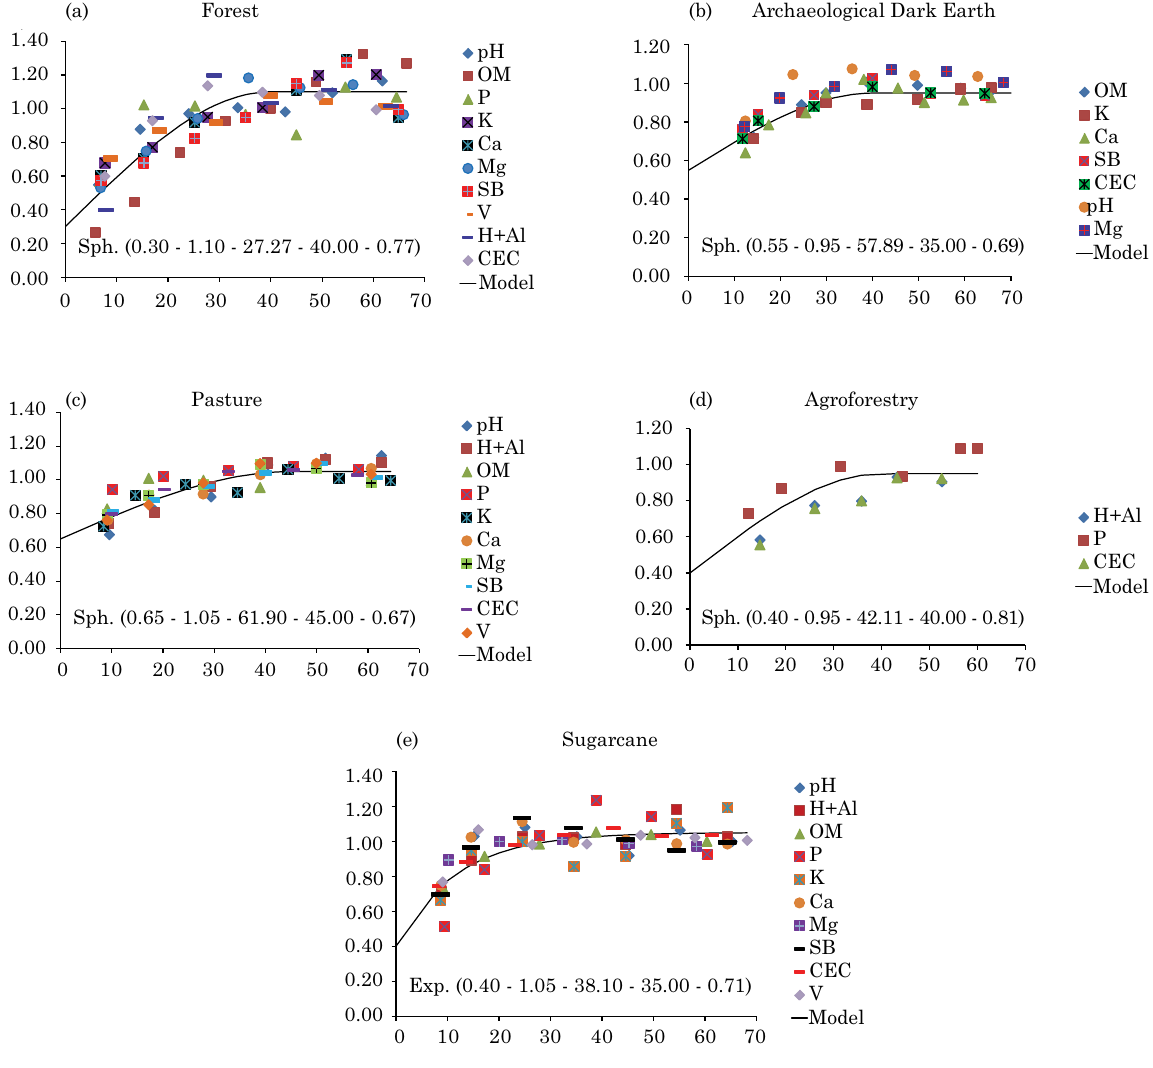
Figure 2. Scaled semivariograms for chemical properties of environments in municipalities of Humaitá and Manicoré in southern Amazonas. Exp.: exponential; Sph.: spherical; [model (nugget effect - sill - DSD - R 2 - range - residue)]. DSD: degree of spatial dependence; R 2 : coefficient of